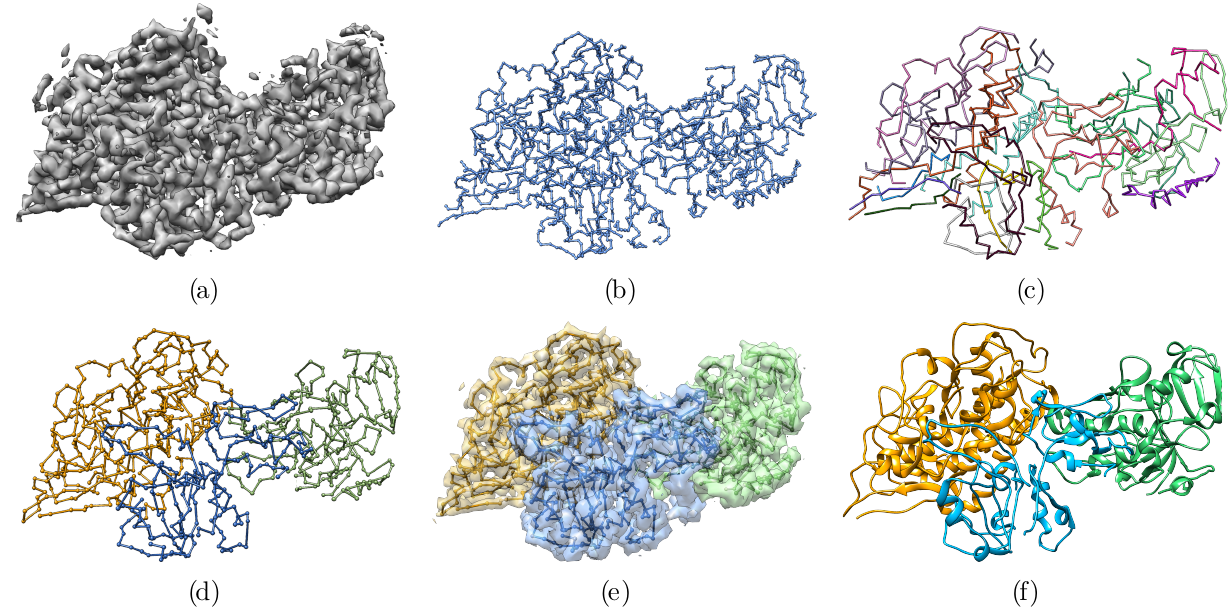
Figure 2. Overview of the automatic reconstruction of an atomic protein structure from an EM density map. ( a ) Original EM density map used as input of the algorithm. ( b ) Minimum spanning tree (MSTree) derived from the EM density map. ( c ) Fragments resulting from the fork pruning procedure of the MSTree. ( d ) Chains built from the fragments. Fragments were merged in a way to maximize the overlap with predicted contacts. Chains A, B, and C were detected automatically without any prior segmentation of the EM density map. ( e ) Segmented map built from the threading of the 3 chains depicted in ( d ). ( f ) Full-atom model derived from the C α tracing in ( d ) with Modeller and the real_space_refine tool from the Phenix software